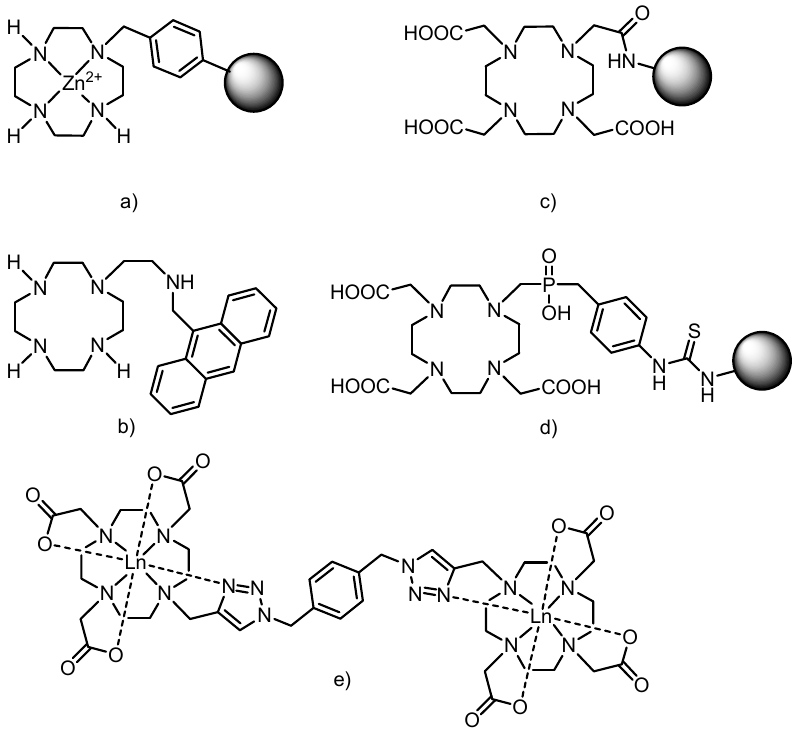
Figure 2. Examples of structures combining macrocycles with each other or with other molecules of interest. ( a ) Zn(II)-cyclen part connected to a polymer (represented as a sphere). ( b ) Cyclen modified with anthrylmethylamino group. ( c ) DO3A moiety connected by the amide bridge to G0–G5 poly(amidoamine) (PAMAM) dendrimers (represented as a sphere). ( d ) Thiourea bridge between the macrocycle and G2 PAMAM dendrimer (represented as a sphere). ( e ) Example of two macrocycles connected via “click chemistry” reaction (copper catalyzed [3+2] cycloaddition between alkyne and organic azide) and the mode of lanthanide